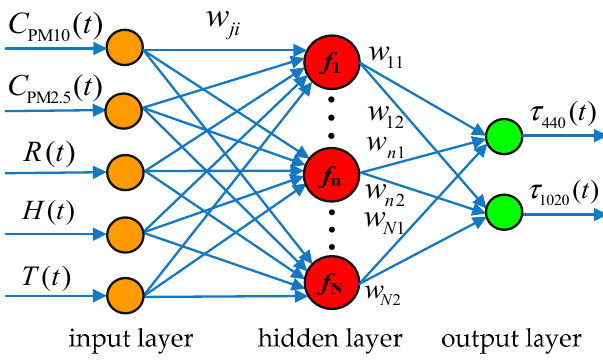
Figure 2. Structure of the back propagation (BP) neural network model.